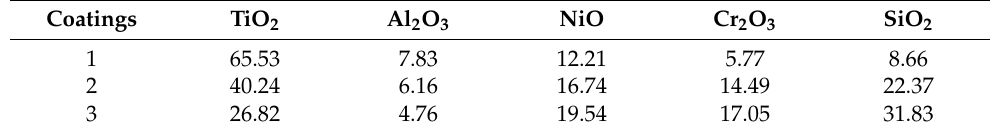
Table 6. Oxides contents in the oxidation film formed on the coatings